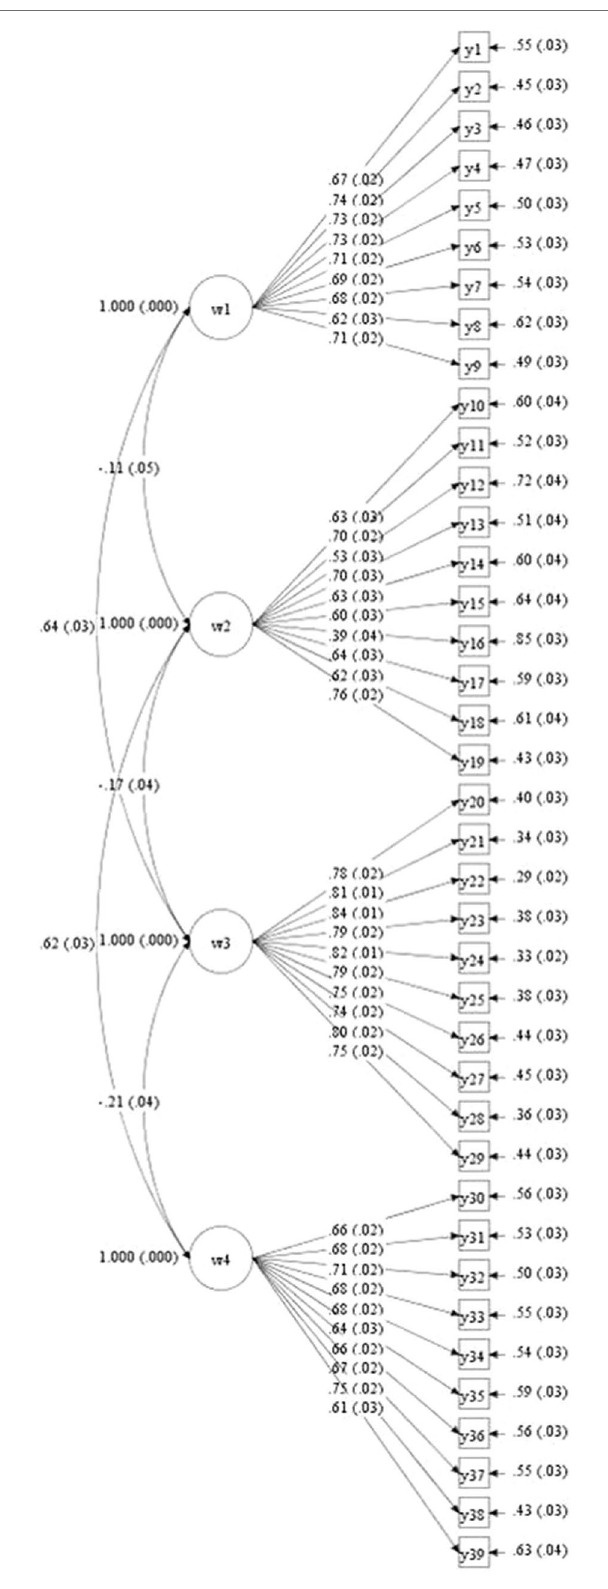
FIGURE 3 | Four-factor model for the PBGEC and individual